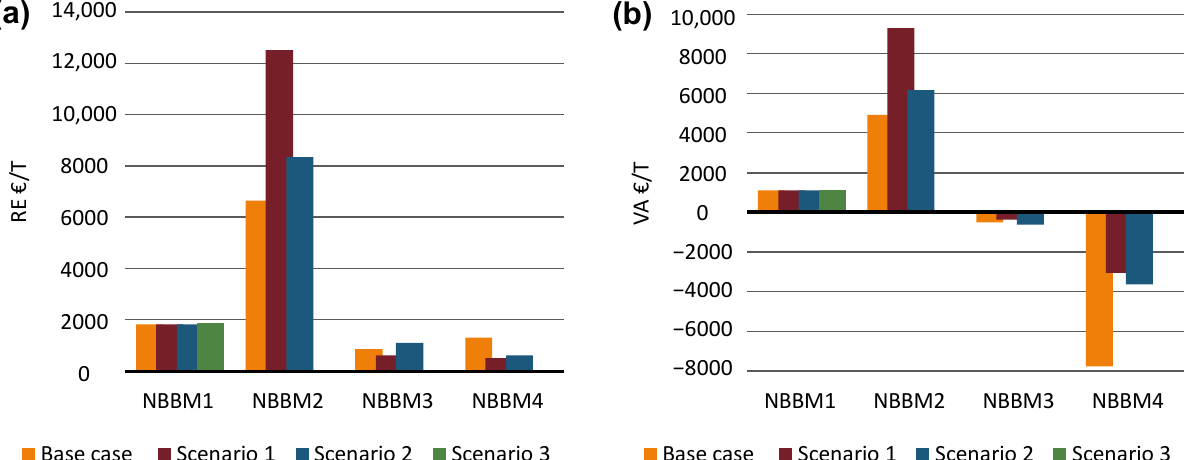
Figure 3. Revenue ( a ) and value added ( b ) of NBBMs in four scenarios.